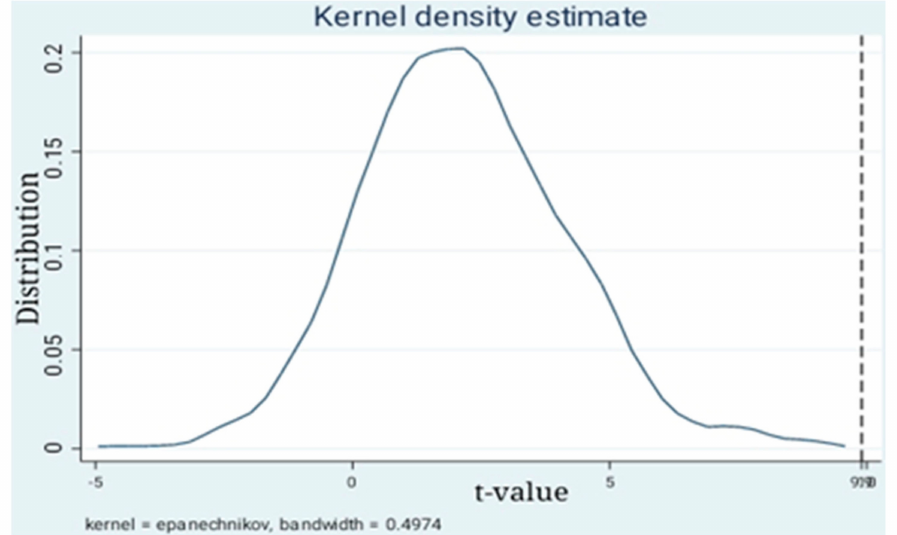
Figure 3. Results of the placebo test. Note: Parameter estimates (dots) and corresponding 95% confidence intervals (lines) are based on Model